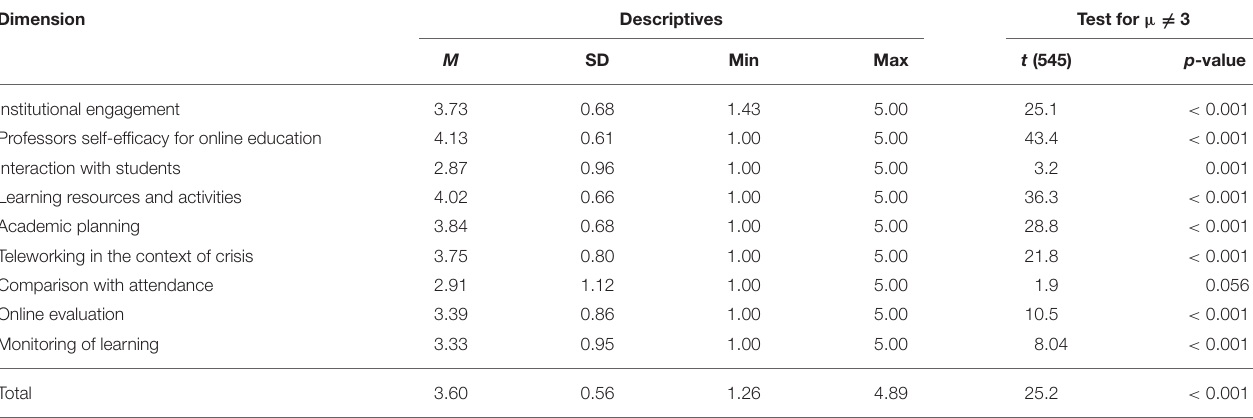
TABLE 3 | Descriptive statistics of CEEVES-D dimensions. Dimension